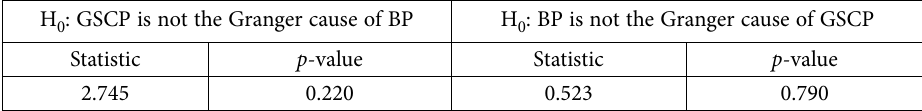
Table 2. The outcomes of bootstrap full-sample method (source: authors’ calculations) H 0 : GSCP is not the Granger cause of